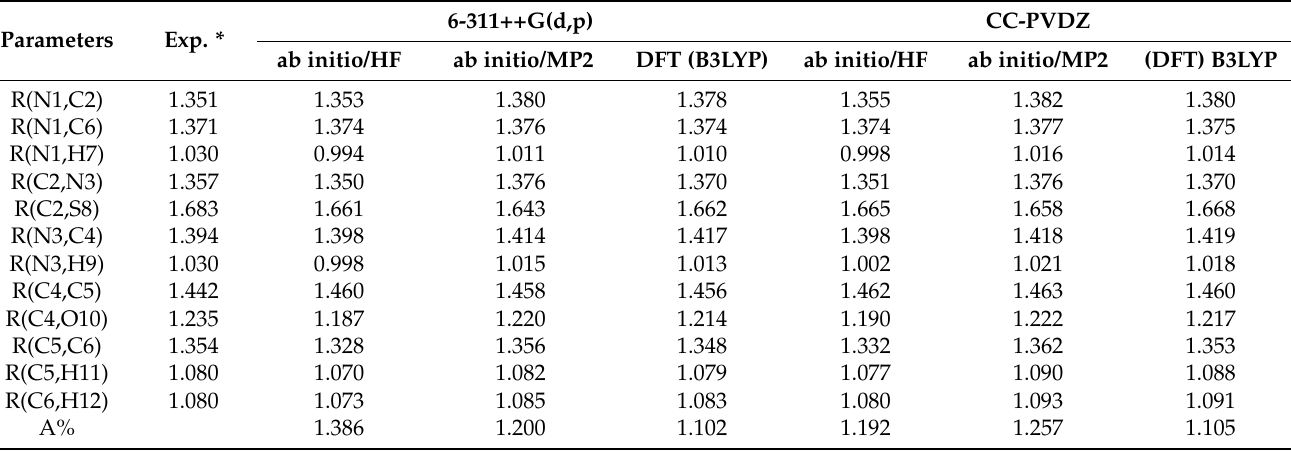
Figure 3. Optimized geometry, numbering system, vector of dipole moment of thiouracil. Table 1. The experimental bond length and computed values of the thiouracil (TU) nucleus at different levels of calculations in the gas